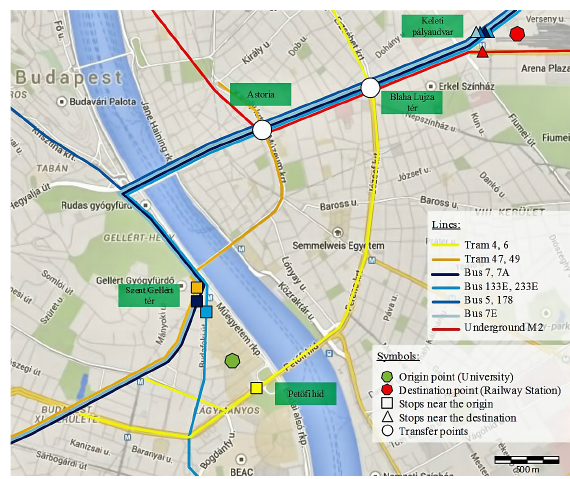
Fig. 5. The example area (source: research by the authors)